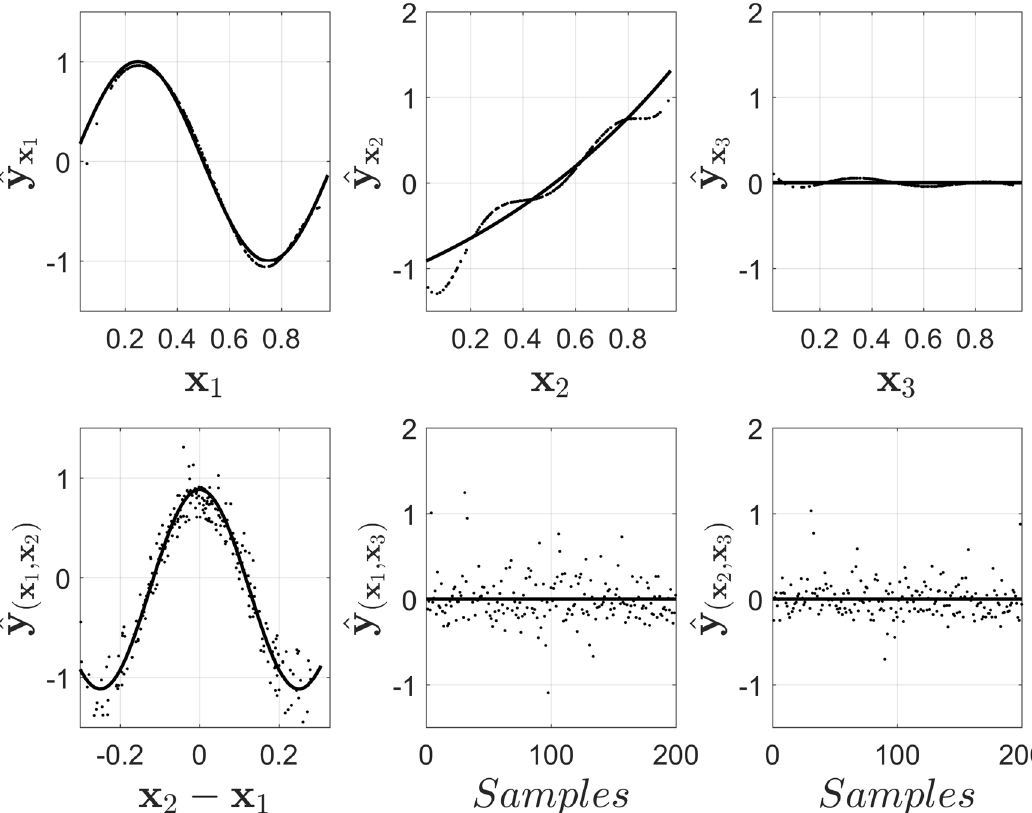
Fig 8. Results provided by NObSP using unseen data. The size of the test set was 250 samples. the samples were obtained in the same way as the training samples were produced. The solid line represents the reference functional forms, while the dots represent the output of the decomposition scheme.